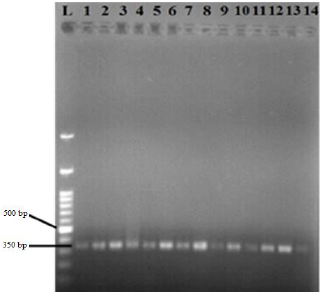
Fig. 2. Electrophoresis pattern of RT-PCR products in 1% agarose gel. Lane L: Gene Ruler 100 bp DNA Ladder plus (MBI Fermentas, Germany), Lane 1-14: DNA bands of the expected size (350bp) with Nib2F / Nib3R primer pair from symptomatic squash, cucumber, melon, and watermelon